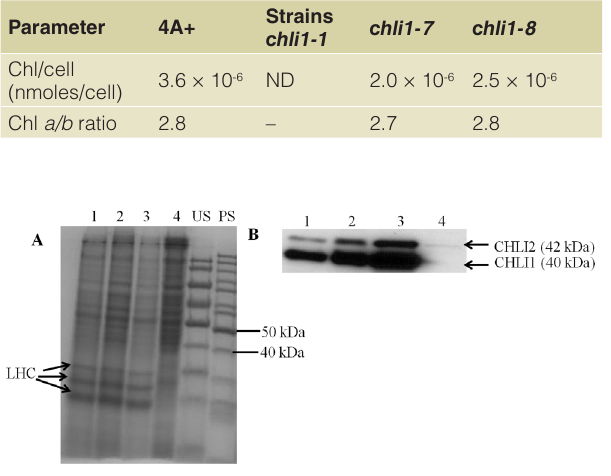
Figure 11. SDS-PAGE and Western analyses. ( A ) A stained protein gel. Lanes 1, 2, 3 and 4 represent chli1-8 , chli1-7 , 4A+ and chli1-1 , respectively. Light harvesting complex (LHC) protein bands are labeled. PS and US denote pre stained and unstained molecular weight protein ladders, respectively. Total cell extract of different strains were loaded on equal Chl basis (4 μg of Chl) in lanes 1, 2 and 3. In lane 4, 40 μg of protein (the maximum amount of protein that can be loaded on a mini protein gel) was loaded as chli1-1 lacks Chl. ( B ) Western analyses using a CHLI1 antibody generated against the Arabidopsis CHLI1 protein. Lanes 1, 2, 3 and 4 represent chli1-8 , chli1-7 , 4A+ and chli1-1 , respectively. CHLI1 (40 kDa) and CHLI2 (42 kDa) proteins detected by the antibody are labeled.